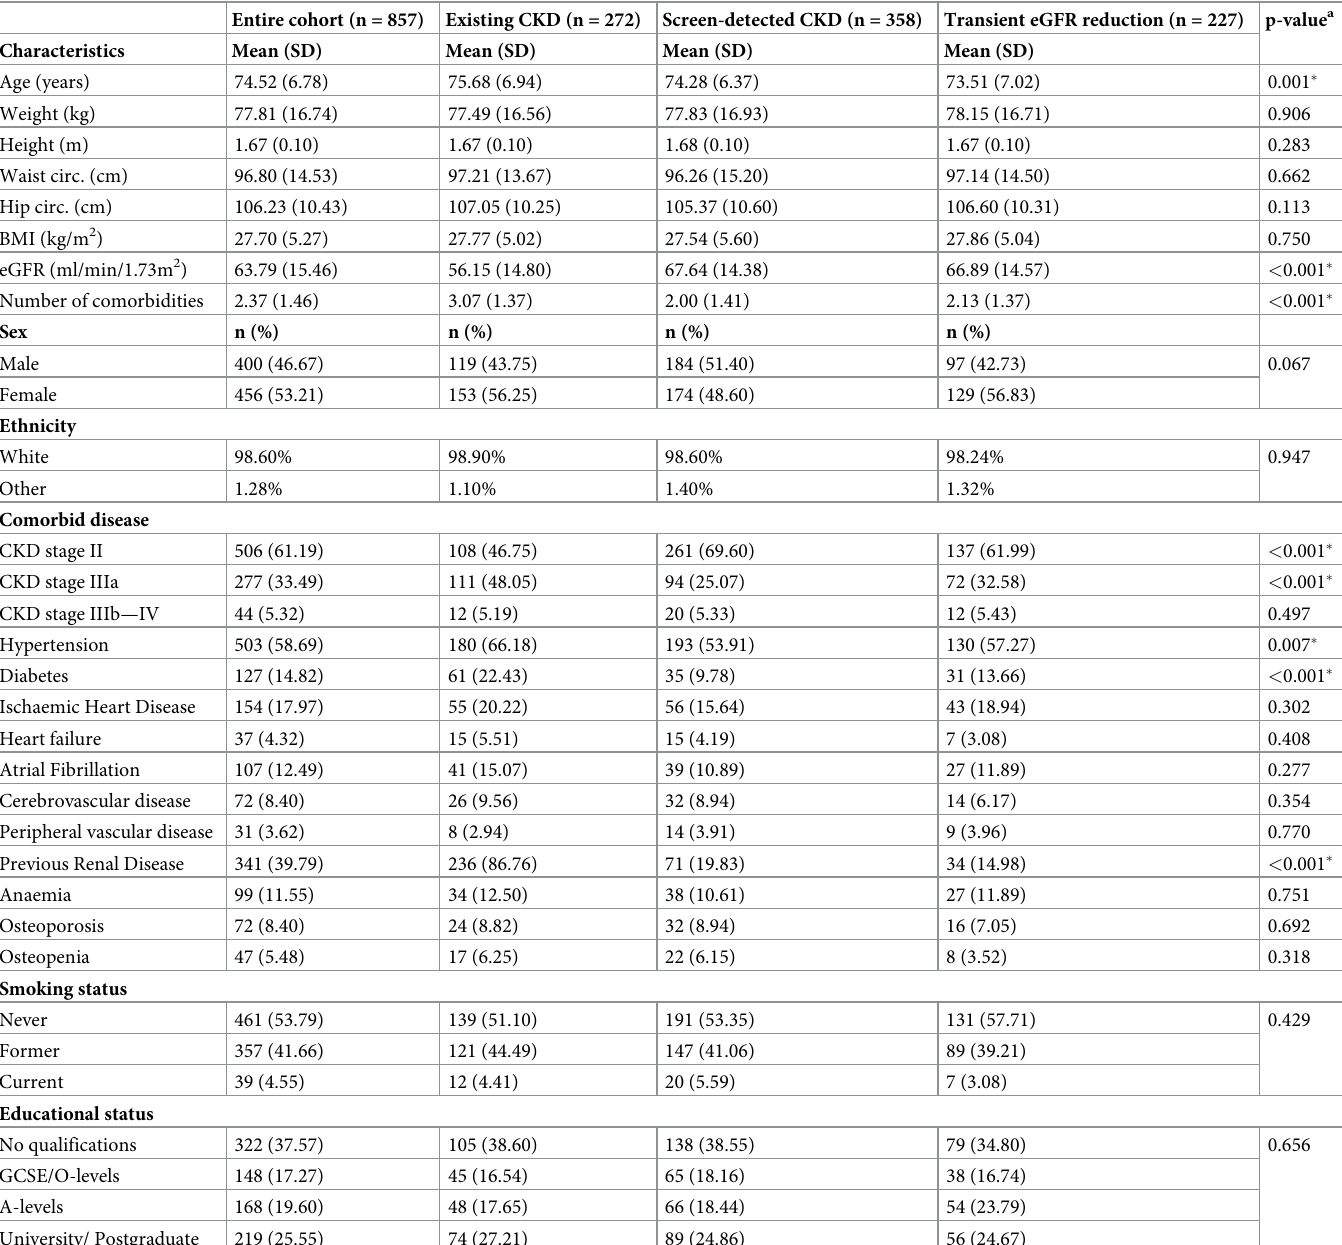
Table 1. Baseline characteristics of the OxRen cohort of older adults from Oxfordshire primary care practices with complete QoL data. Entire cohort (n = 857) Existing CKD (n = 272) Screen-detected CKD (n = 358) Transient eGFR reduction (n = 227) p-value a